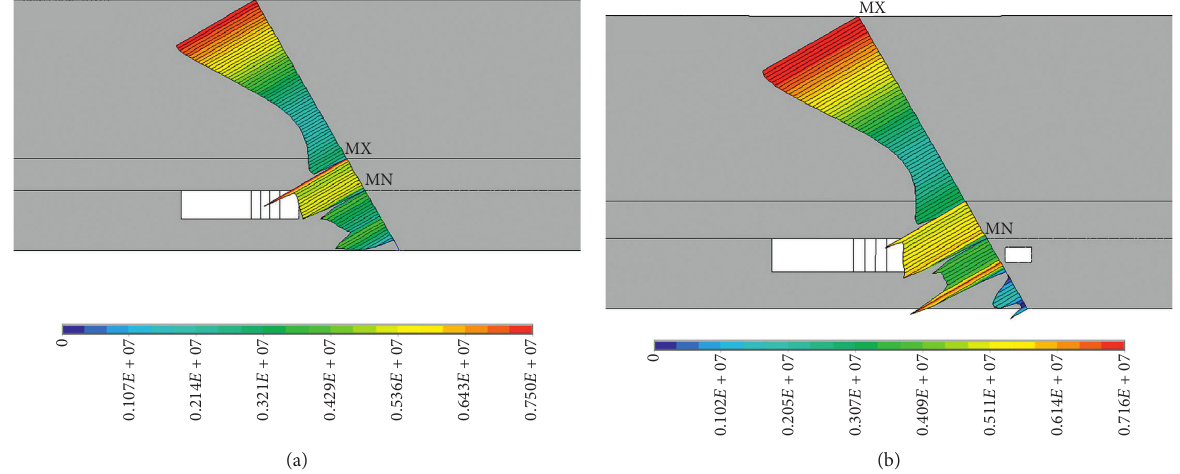
Figure 21: The nephogram of contact pressure when work face is near the fault (forward direction fault). (a) Without searching tunnel [25, 26]. (b) With searching